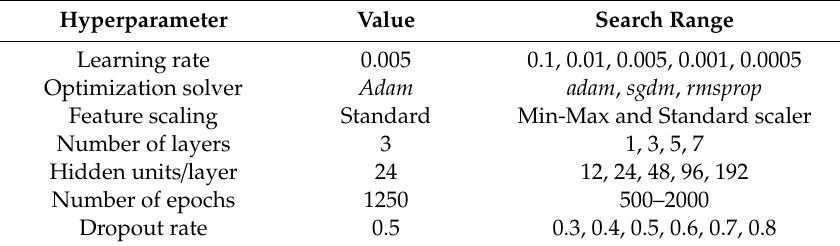
Table 5. Hyperparameter optimization for LSTM model.